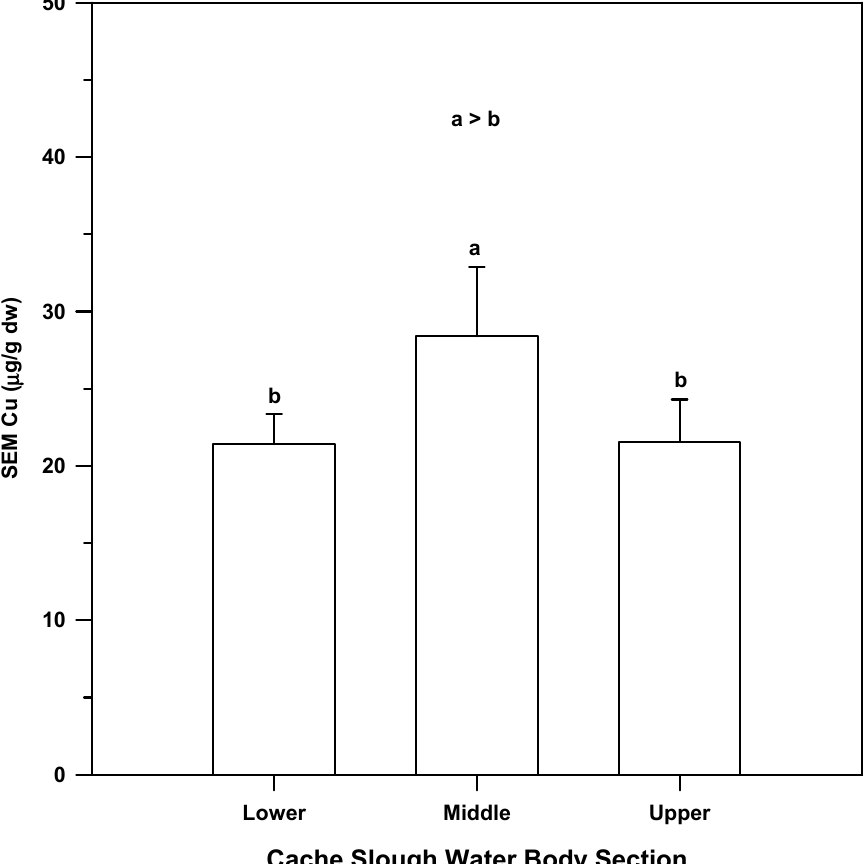
Figure 18. All Cache Slough SEM Cu sediment data by lower, middle and upper (four sites each) water body sections (Kruskal-Wallis ANOVA, p = 0.004). a,b: The middle section is significantly different from the lower and upper sections (Holm-Sidak method, p ≤ 0.050).